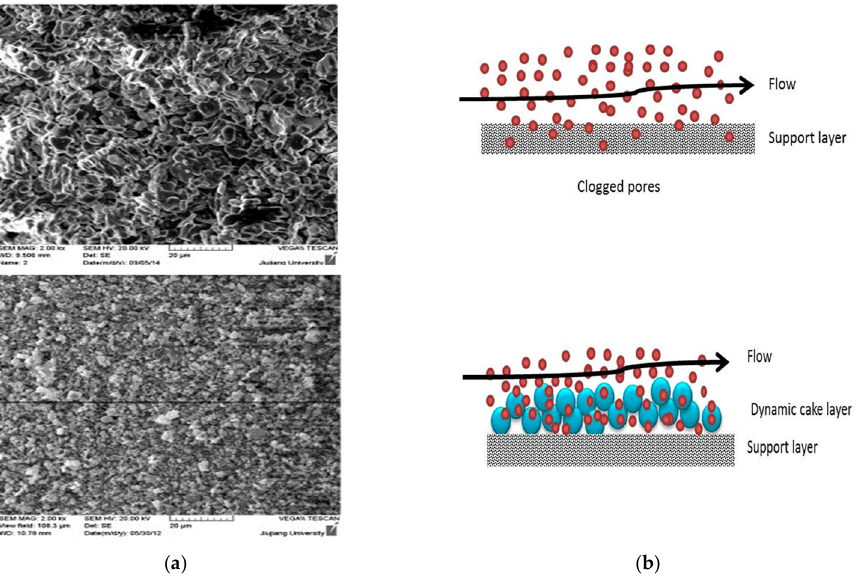
Figure 16. SEM images of the surface of ( a ) ceramic inorganic membrane and ( b ) Kaolin dynamic membrane [351]. Kaolin dynamic membrane show smaller pore size in the range of 0.18 μ m where ceramic membrane has pore size in range of 0.83 μ m. Reproduced with permission from [351].